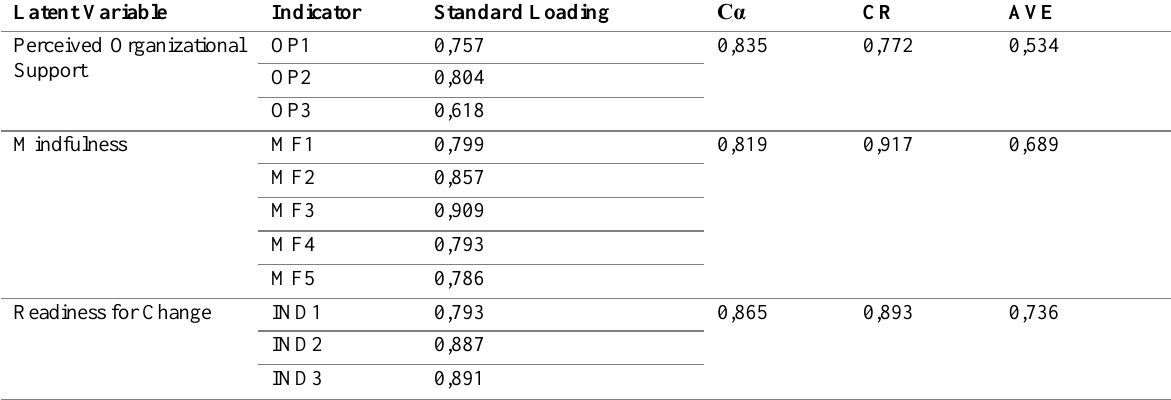
Table 2: Data Reliability